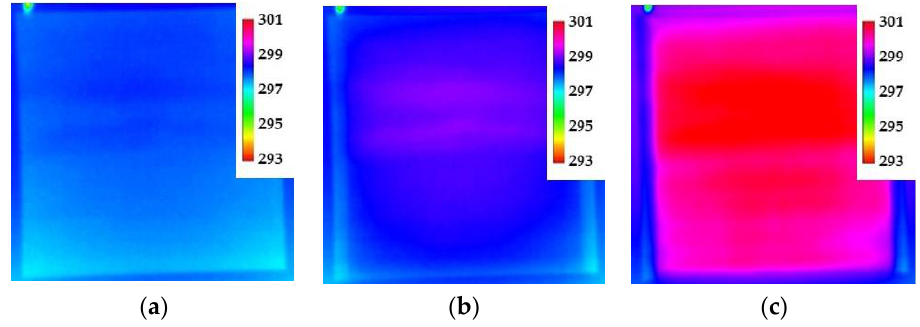
Figure 5. IR images from a larger panel painted with a CNT heater layer: ( a ) No current applied; ( b ) 70 W (32 V, 2.2 A); and ( c ) 385 W (74 V, 5.2 A). Color scale is temperature (K).